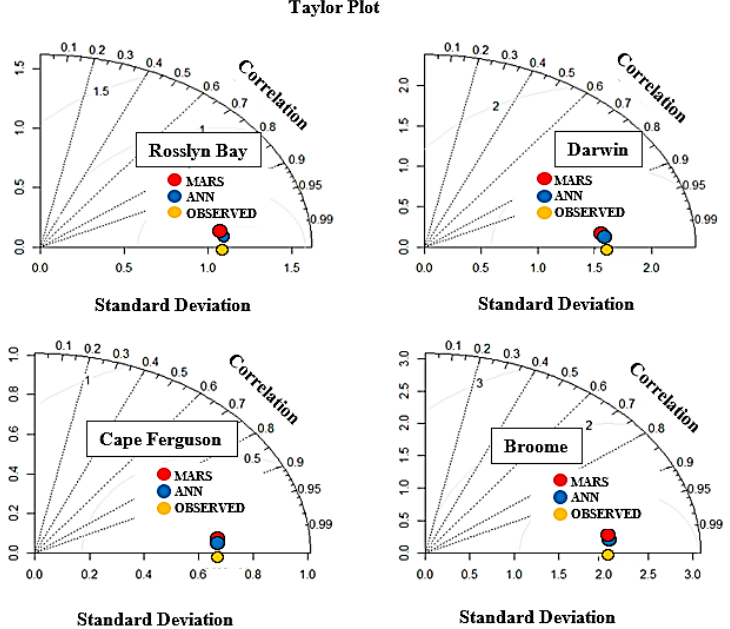
Figure 11. Taylor plot shows the observed, predicted MARS and ANN with standard deviation and correlation. The horizontal and vertical axes show standard deviation values with correlation values on the arc.